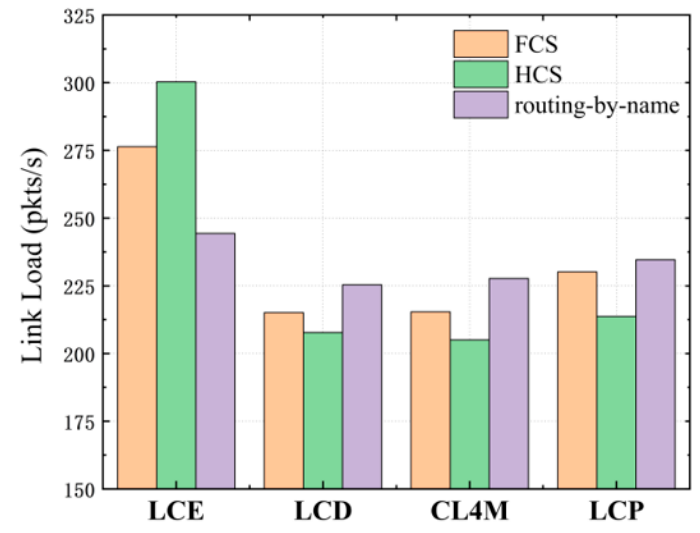
Figure 9. Average link load in overall network.